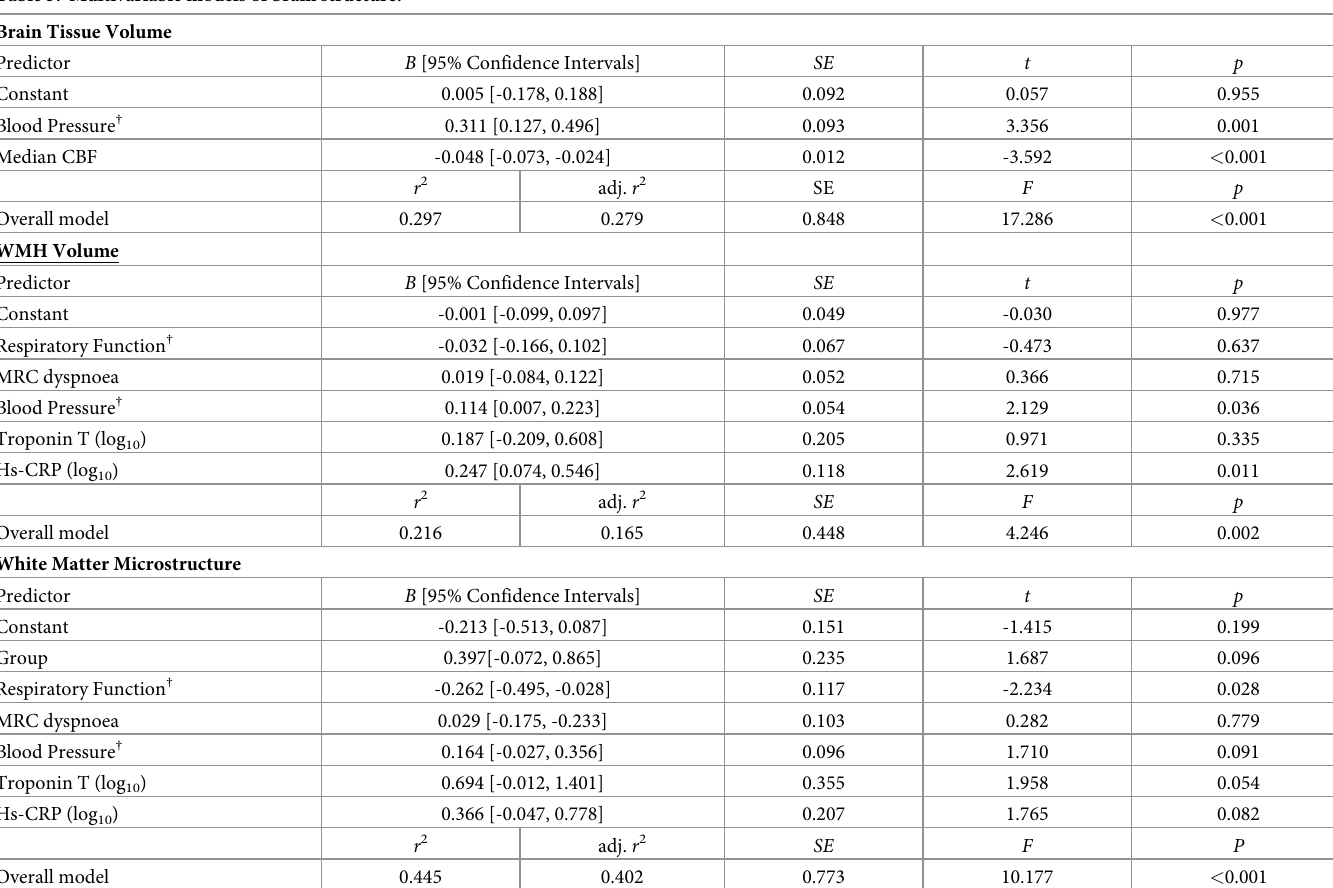
Table 5. Multivariable models of brain